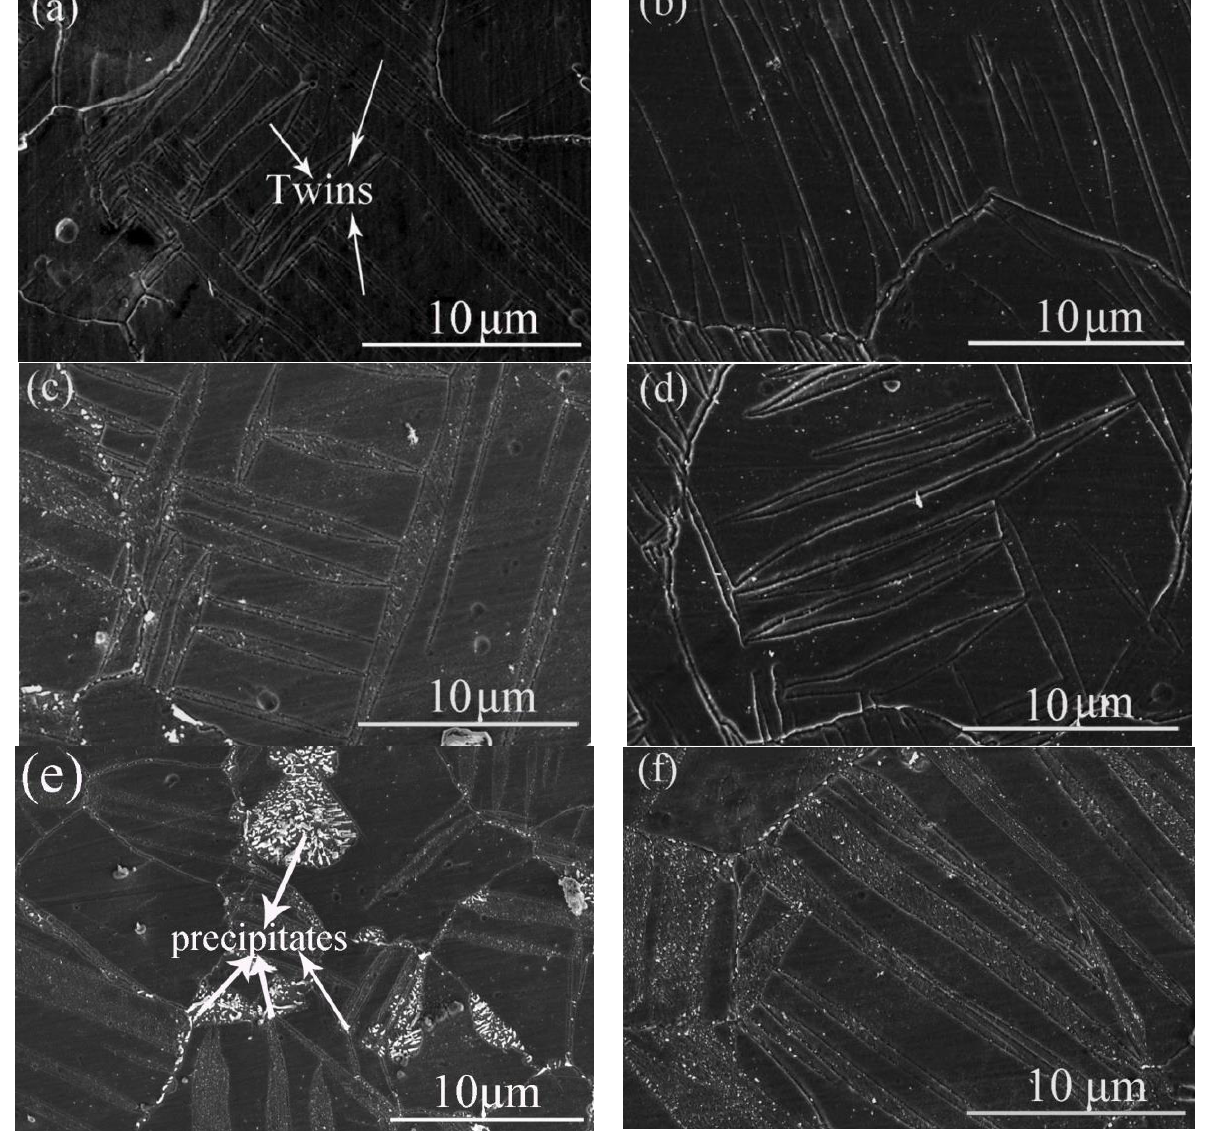
Figure 5. SEM micrographs demonstrating the microstructure of ( a ) the sample subjected to 175 MPa, ( b ) the sample subjected to 175 MPa and then aged at 170 °C for 1 h, ( c ) the sample subjected to simultaneous loading (175 MPa) and aging at 170 °C for 1 h, ( d ) the sample subjected to 175 MPa and then aged at 170 °C for 3 h, ( e ) the sample subjected to simultaneous loading (175 MPa) and aging at 170 °C for 3 h and ( f ) the sample subjected to 175 MPa and then aged at 170 °C for 10 h.